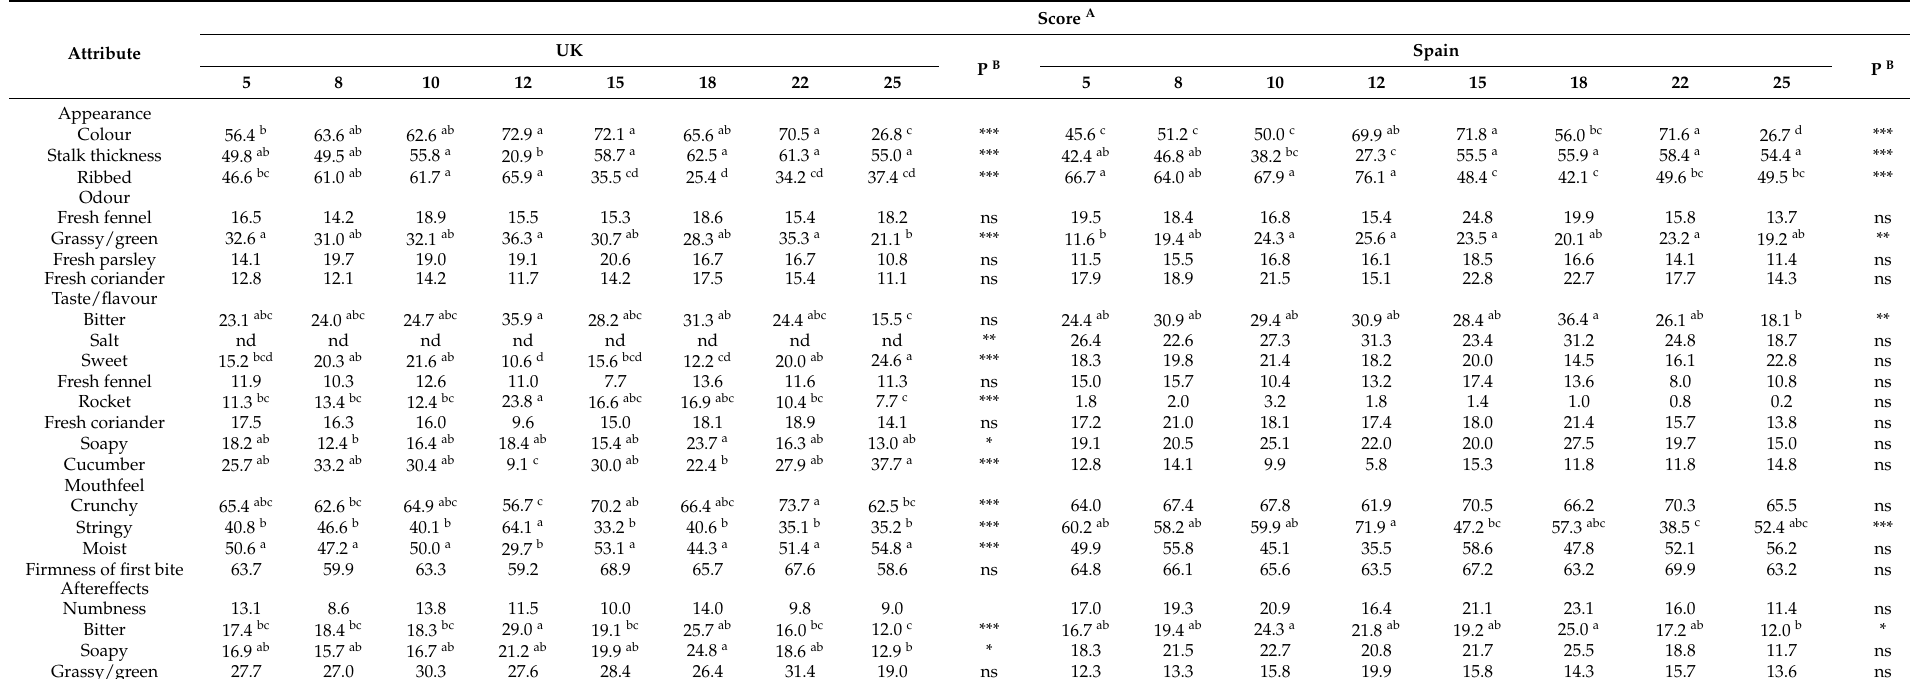
Table 2. Mean panel scores for sensory attributes of the eight celery samples harvested in UK 2018 and Spain